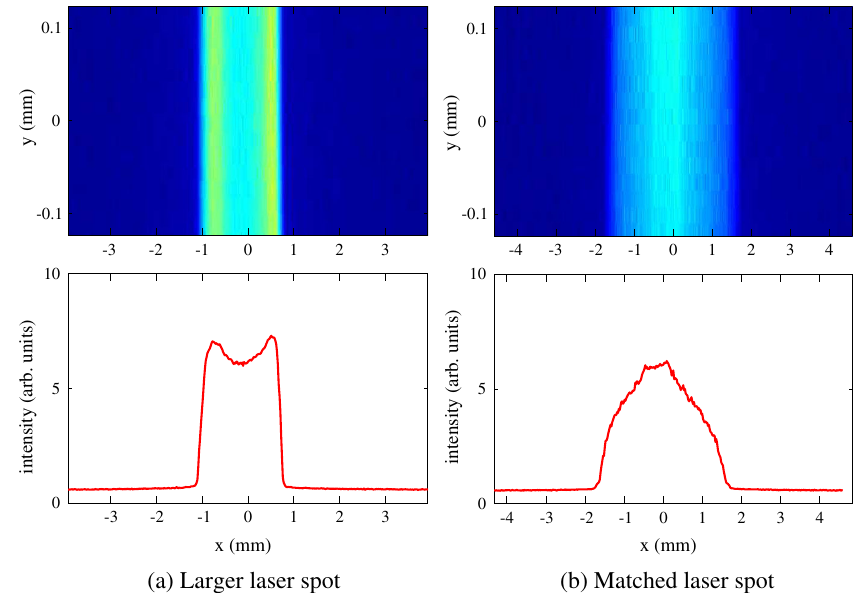
FIG. 6. (Color) Central slice images (upper plots) and horizontal profiles (lower plots) showing both the double-horn (a) and more Gaussian-like (b) energy distributions.